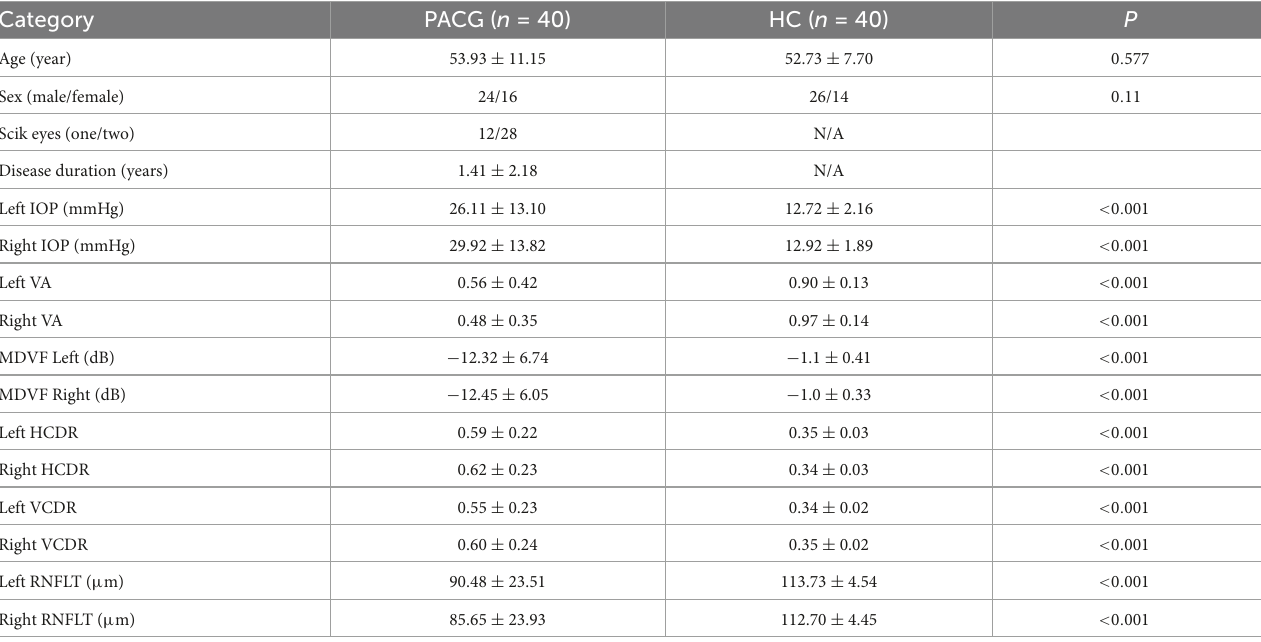
TABLE 1 Demographic characteristics in primary angle-closure glaucoma (PACG) subjects and healthy control (HC). Category